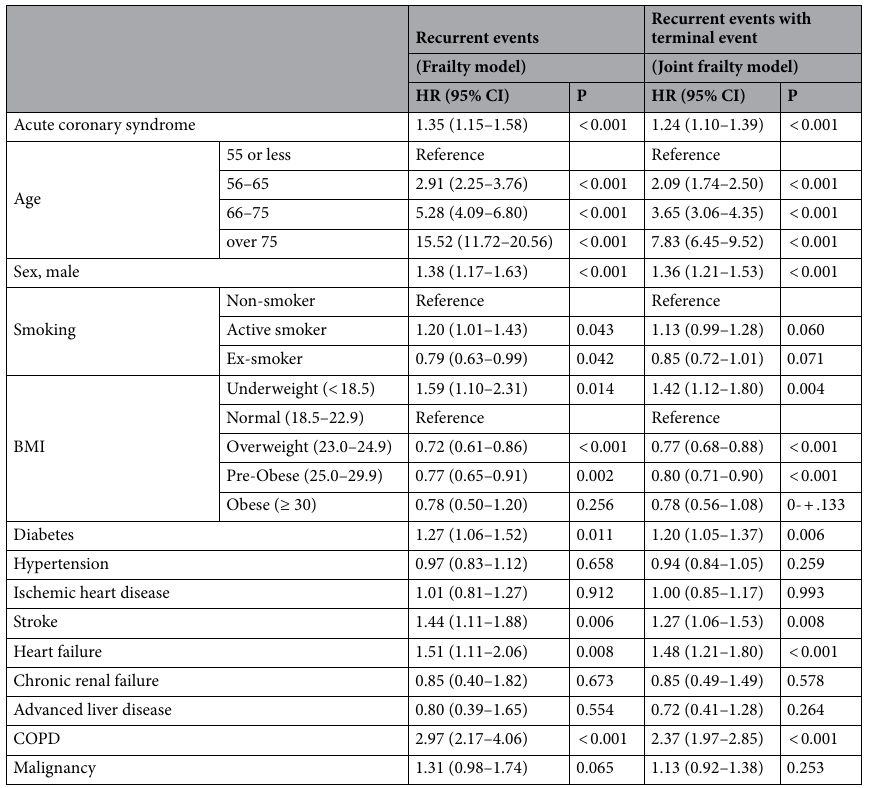
Table 3. Frailty and joint frailty model of recurrent pneumonia event. BMI: Basal mass index; COPD: Chronic obstructive pulmonary